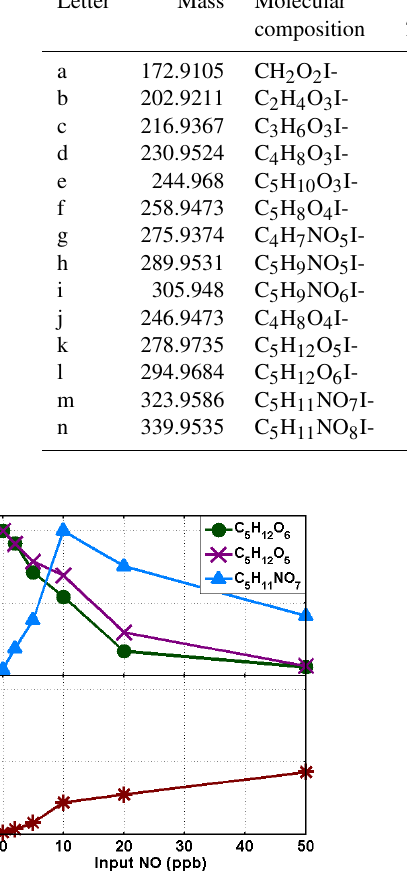
Figure 3. Top: normalized signals of C 5 H 12 O 6 and C 5 H 11 NO 7 , believed to originate in the gas phase from the same C 5 H 11 O 6 per- oxy radical and C 5 H 12 O 5 , as a function of input NO. Signal is nor- malized to maximum signal for each compound to show the rela- tive behaviors. Bottom: the mass fraction of organic nitrates as a function of NO. Mass fraction refers to the mass concentration of FIGAERO-CIMS-measured OrgN relative to the total mass concen- tration of organics (non-nitrogen containing + OrgN) measured by the